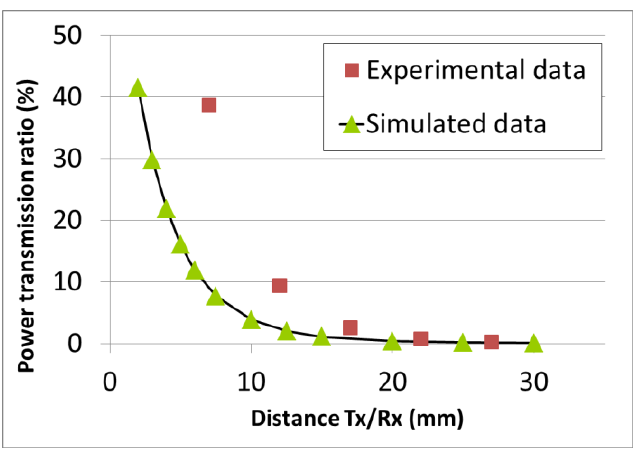
Figure 6. Power transmission ratio vs.